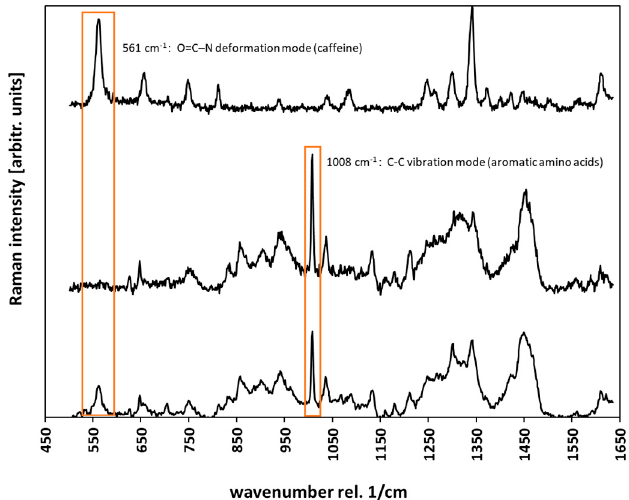
Figure 2. Raman spectra of a 2% caffeine solution (top), stratum corneum (middle) and stratum corneum incubated with caffeine (bottom). The peaks used for calculation of the depth profiles are marked orange.